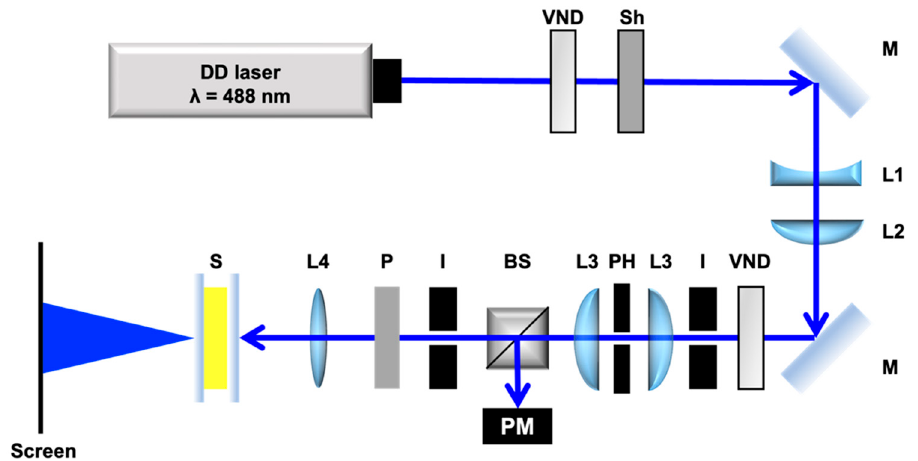
Figure 4. Optical setup for self-diffraction ring measurement. VND, variable neutral density filter; Sh, shutter; M, mirror; L1, plane concave lens ( f = − 80 mm); L2, plane convex lens ( f = 150 mm); I, iris; L3, plane convex lens ( f = 70 mm); PH, pinhole; BS, beam splitter; PM, power meter; P, polarizer; L4, biconvex lens ( f = 150 mm); S, sample.